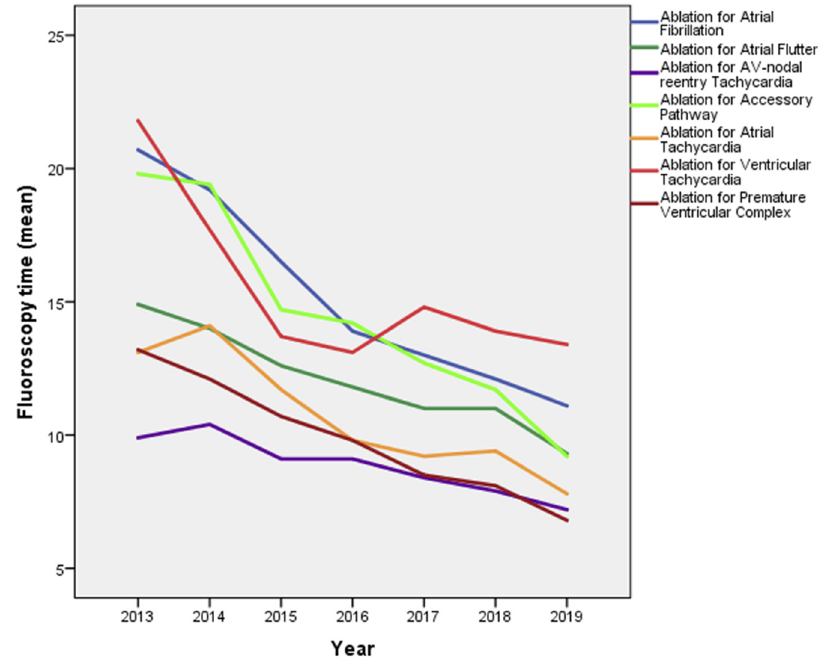
Figure 2. Fluoroscopy durations during from 2013 till the end of 2019.